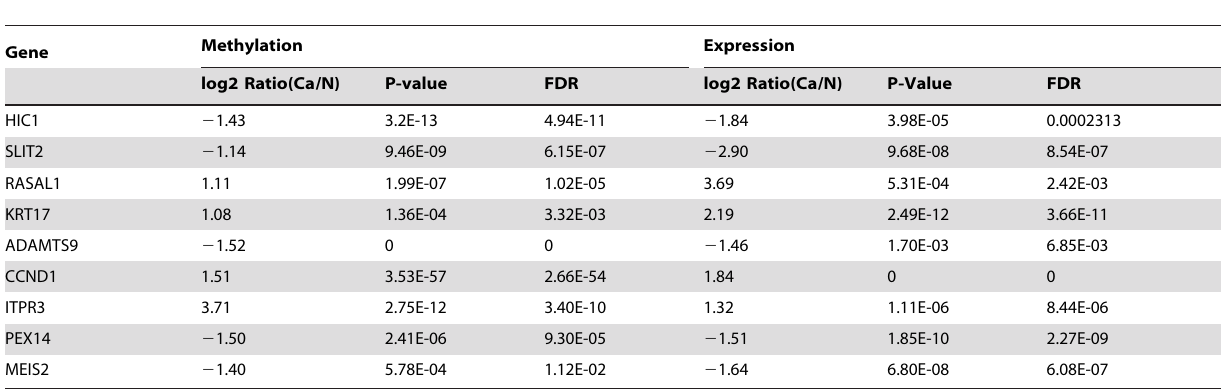
Table 2. A collection of significantly deregulated genes detected by deep sequencing in bladder cancer.